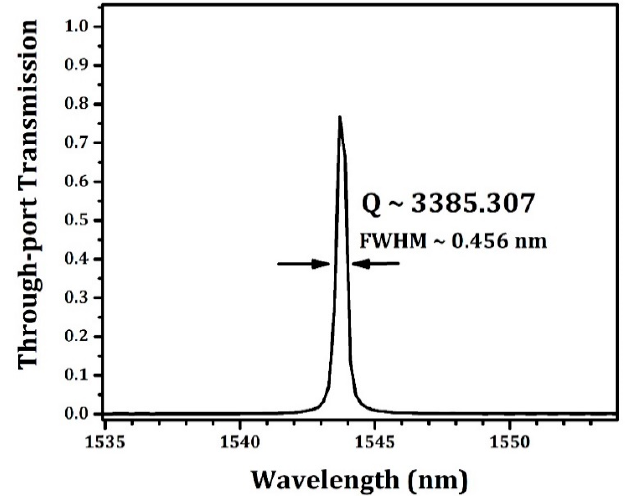
Figure 6. The simulation result of the transmission at the through-port of MRR for index background of air (n = 1).